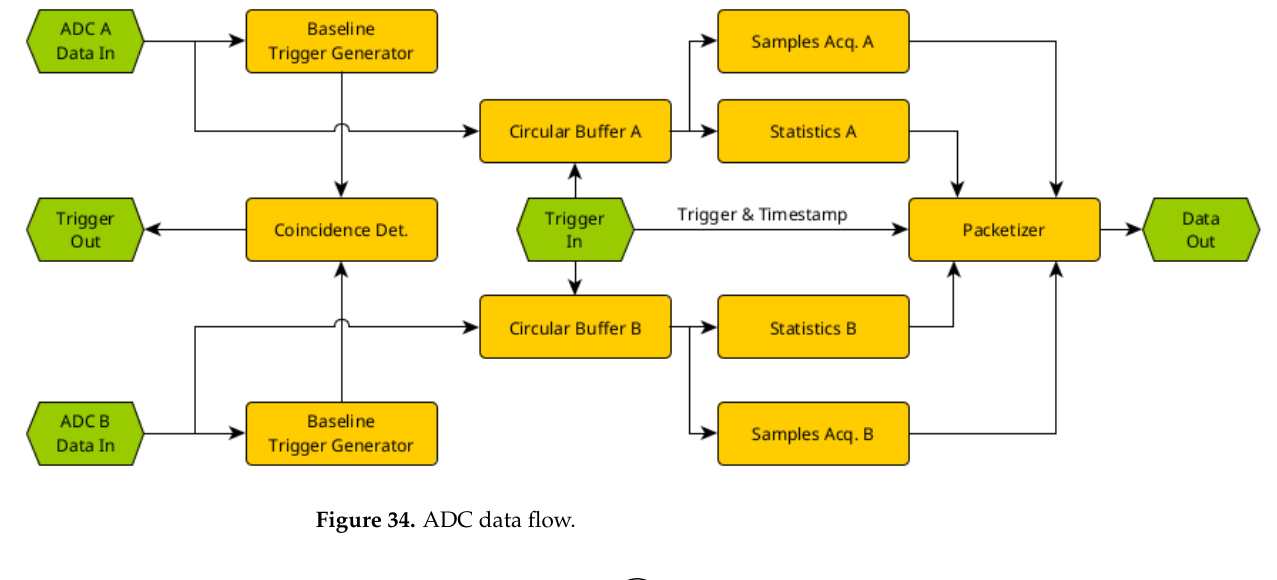
Figure 34. ADC data flow.